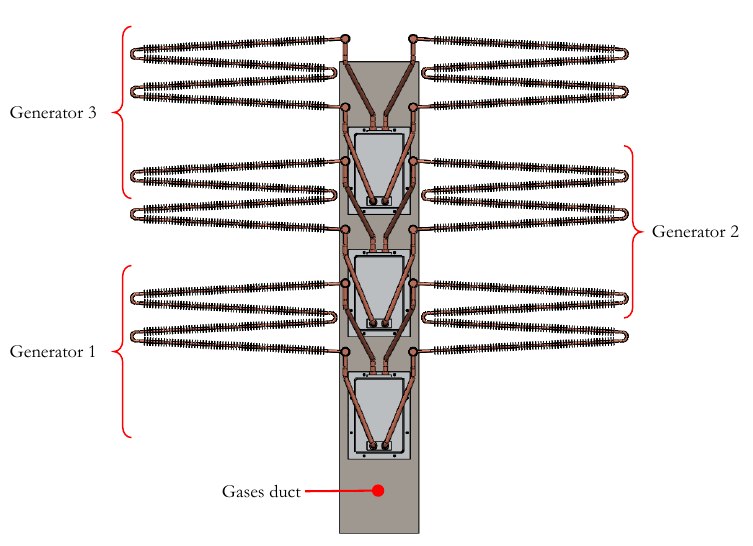
Figure 8. Installation scheme of several thermoelectric generators with biphasic thermosyphons on the same exhaust duct.